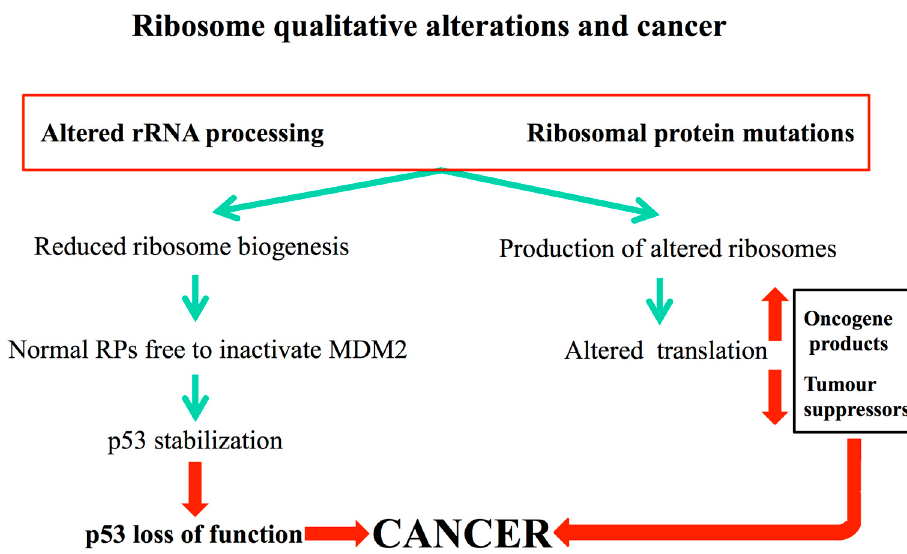
Figure 6. How qualitative alterations of ribosome biogenesis in ribosomopathies may lead to cancer; conditions qualitatively altering ribosome biogenesis include alterations in the rRNA modifying/processing factors and mutations in genes encoding for ribosomal proteins. These conditions (green arrows) can give rise both to a reduced ribosome biogenesis and to the formation of altered ribosomal subunits. Deregulated ribosome biogenesis activates the RP-MDM2-p53 pathway with consequent sustained p53 stabilization. Cells bypass this activation by p53 loss of function. The formation of altered ribosomes leads to unbalanced translation of tumour contrasting and promoting factors. The combined effect of the two different mechanisms would favor cancer onset (red